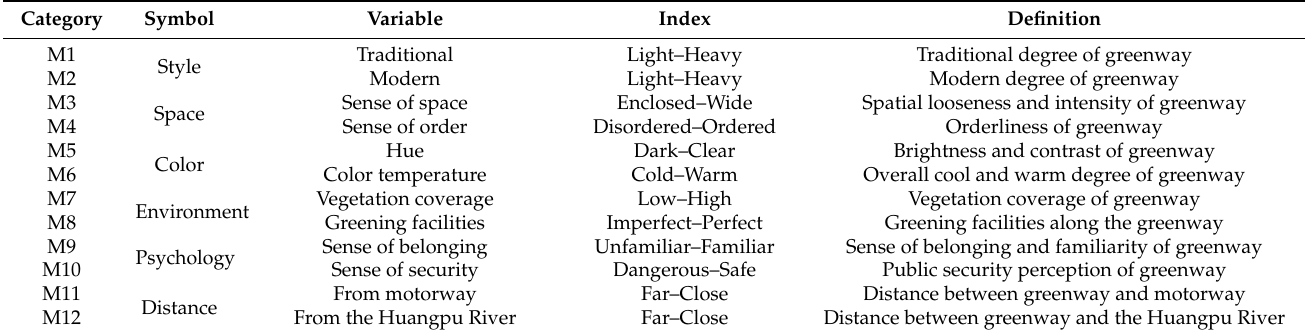
Table 1. The semantic differential scale of residents’ perceptions of riverside